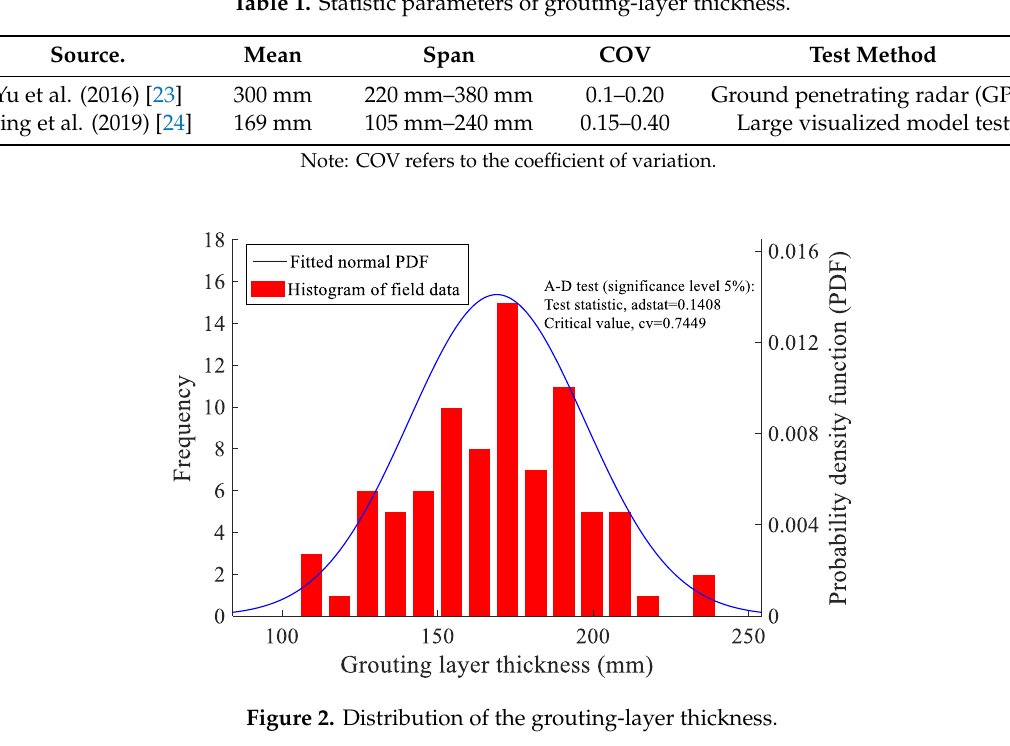
Figure 2. Distribution of the grouting-layer thickness.